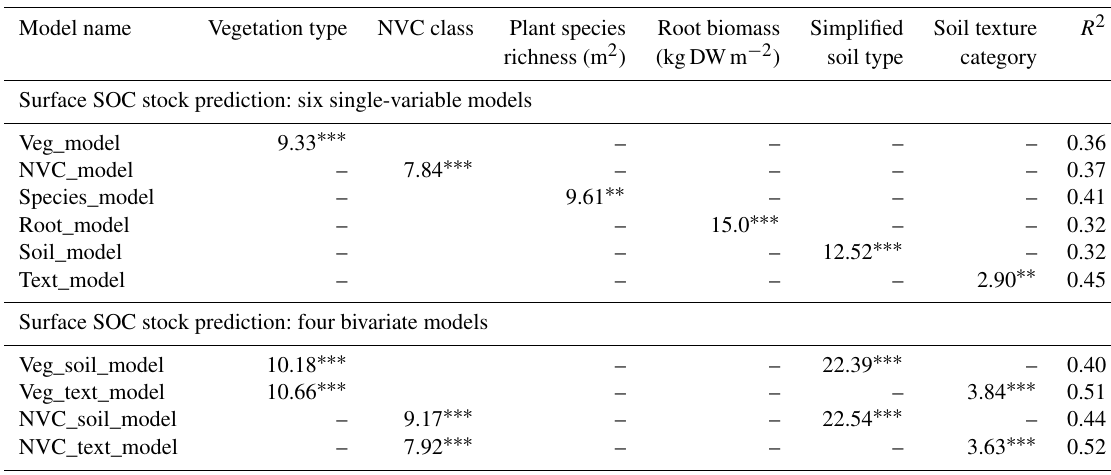
Table 3. Six explanatory variables of surface SOC stock (tCha − 1 ; top 10cm of soil) in Welsh salt marshes, based on ANOVA output from mixed-effect models, with F statistic values